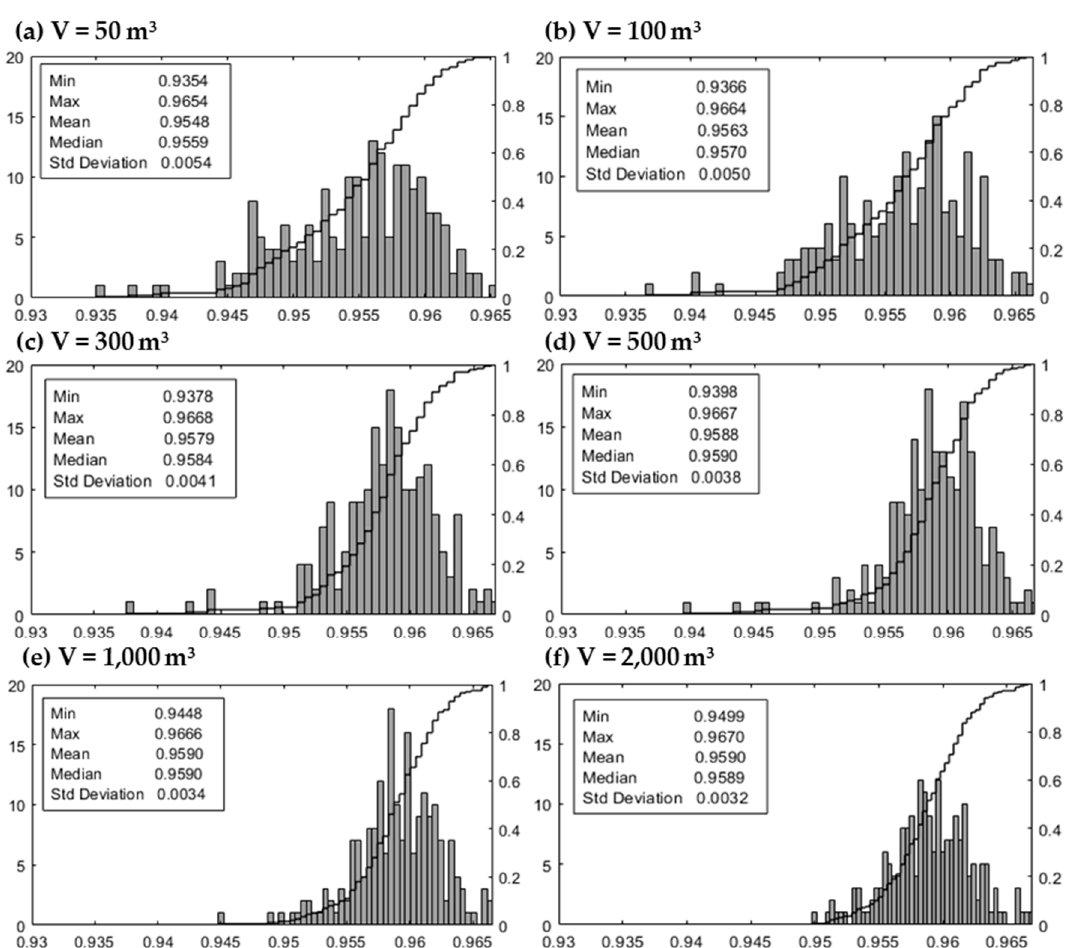
Figure 15. Distribution (bars) and CDF (stairs) of the heart recovery rate (HRR) for ( a – f ) different tank sizes from 50 m³ to 2000 m³.